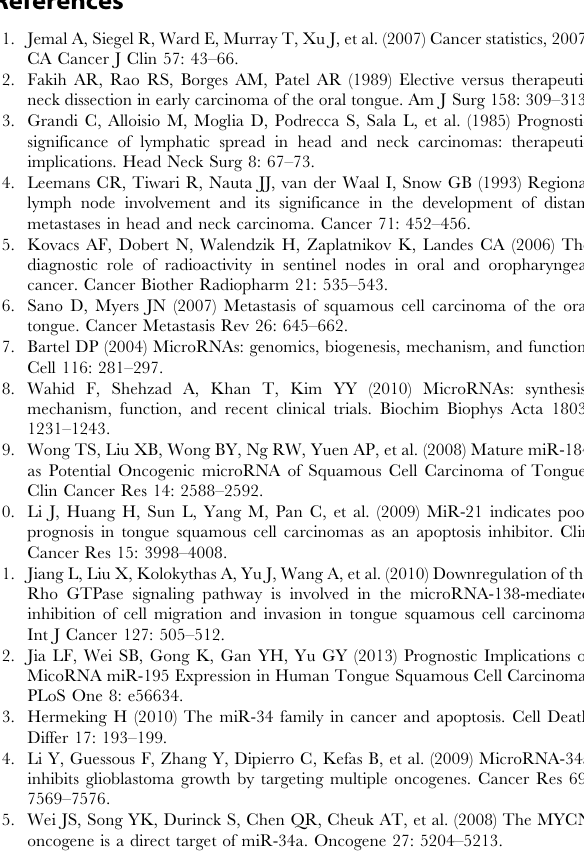
Table S1 The clinical features of TSCC patients with positive and negative lymph node metastases. Table S2 Sequences of RNA and DNA